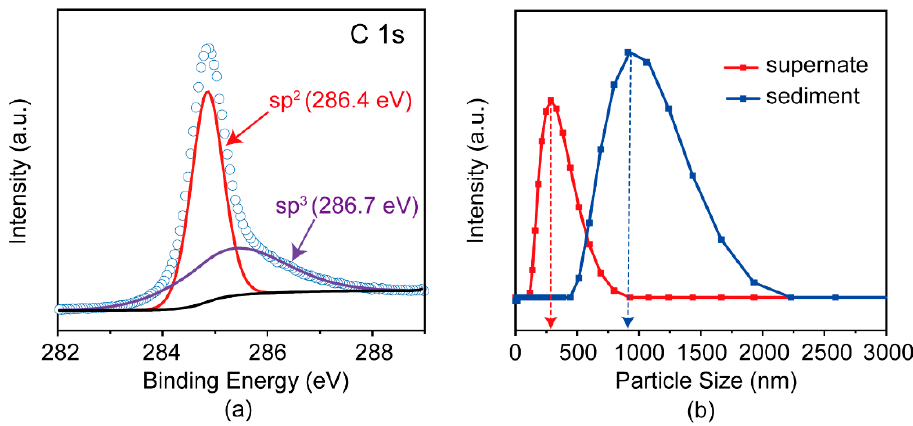
Figure 2. ( a ) XPS analysis of C 1s of the powder sample of NG-3. ( b ) Particle size distribution patterns of the supernate and sediment of NG-3 after centrifugation.